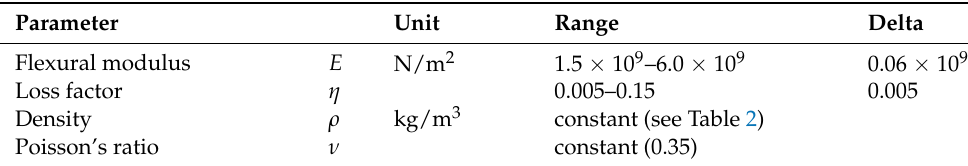
Table 6. Parameter space including assumed constants.